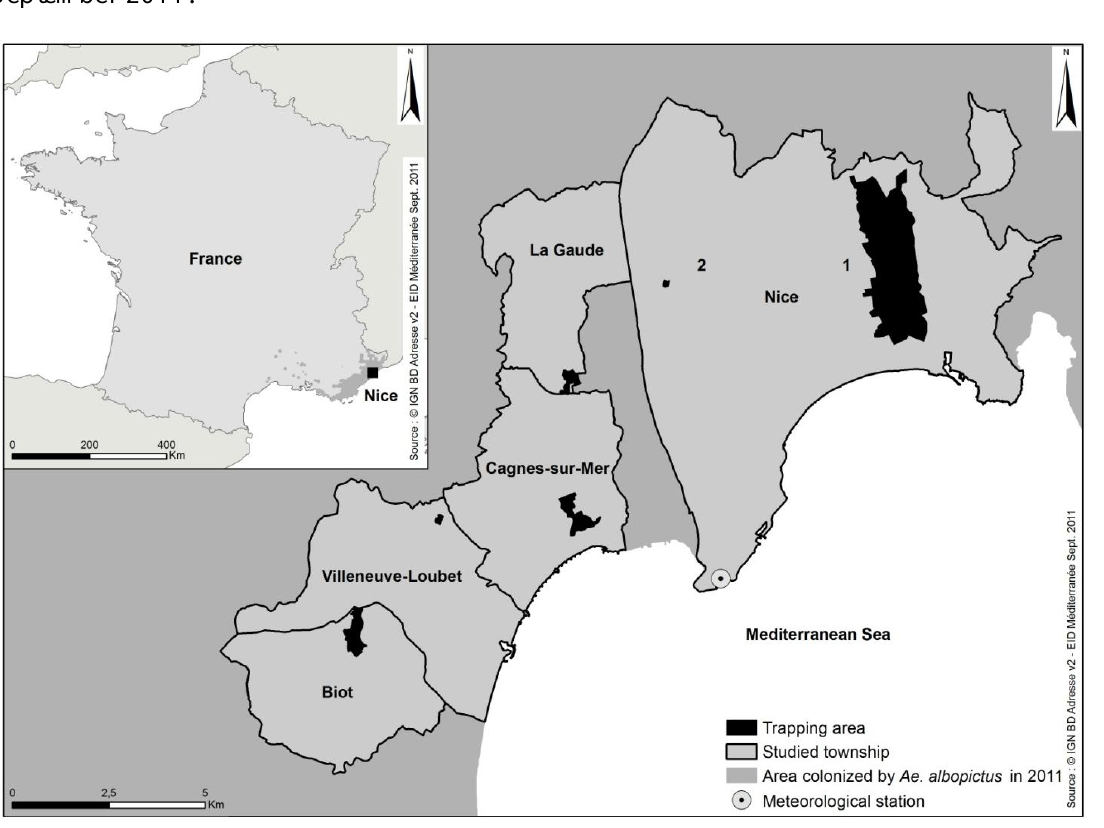
Figure 1. Study area including the municipalities of Nice, La Gaude,